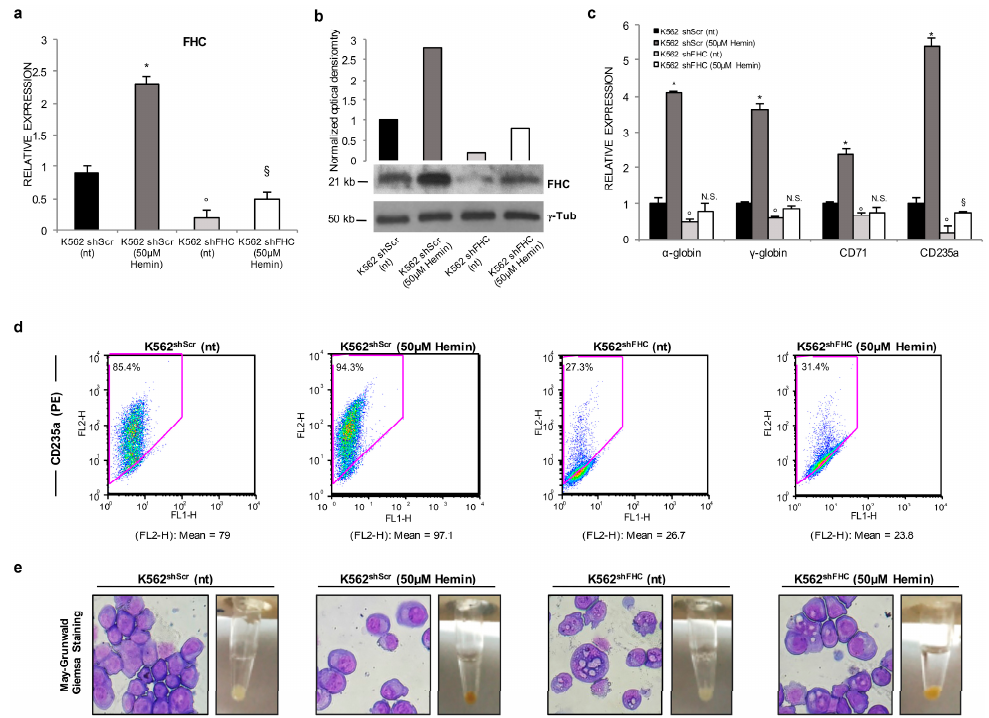
Figure 1. FHC silencing inhibits hemin-induced erythroid differentiation of K562 cells. ( a ) qRT-PCR and ( b ) Western Blot analyses of FHC mRNA and protein levels, respectively, in the control K562 shScr and FHC-silenced K562 shFHC cells untreated (nt) and treated with 50 µM hemin for 48 h; ( c ) Relative expression of α -globin , γ -globin , CD71 and CD235a of K562 shScr and K562 shFHC cells untreated or treated with hemin. All data represent mean ± SD ( n = 3). * p < 0.05 compared with K562 shScr cells, ° p < 0.05 compared with K562 shScr cells, § p < 0.05 compared with K562 shFHC cells, N.S.: not significant; ( d ) Flow cytometry analysis of CD235a-positive cells in K562 shScr and K562 shFHC cells untreated or treated with hemin. Data are reported both as mean fluorescence intensity of CD235a (FL2-H) and as percentage (%) of CD235 + cells; ( e ) May-Grünwald-Giemsa staining of K562 shScr and K562 shFHC cell untreated or treated with hemin.